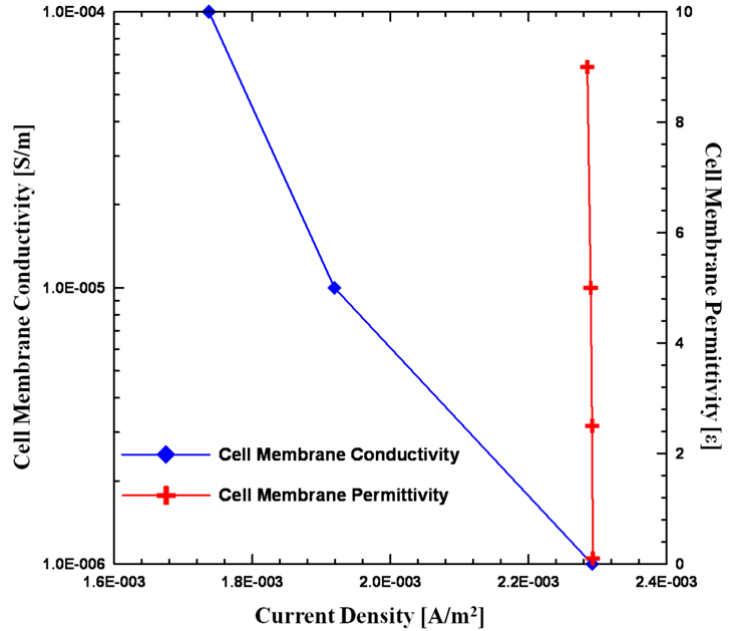
Figure 5. The variation of total current density as changing the cell membrane conductivity and